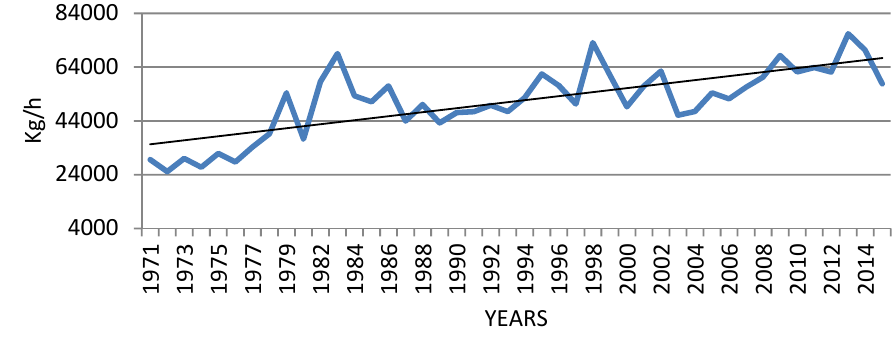
Figure 11. Variation of tea yield over the area of study.